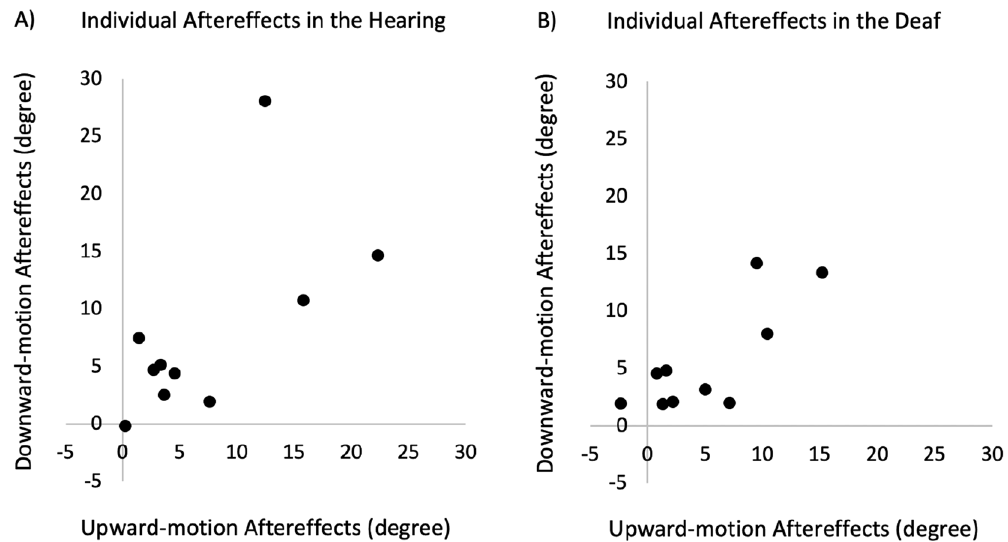
Figure 7. Scatter plots showing individual tactile-to-visual aftereffects in the hearing (Panel A ) and deaf (Panel B ) group. The x-axis represents upward-motion aftereffects (upward-adaptation PSE-baseline PSE), and the y-axis represents downward-motion aftereffects (baseline PSE-downward-adaptation PSE). The unit is degree of visual phase jump. Note that both upward-motion and downward-motion aftereffects plotted here are expected to be positive values.